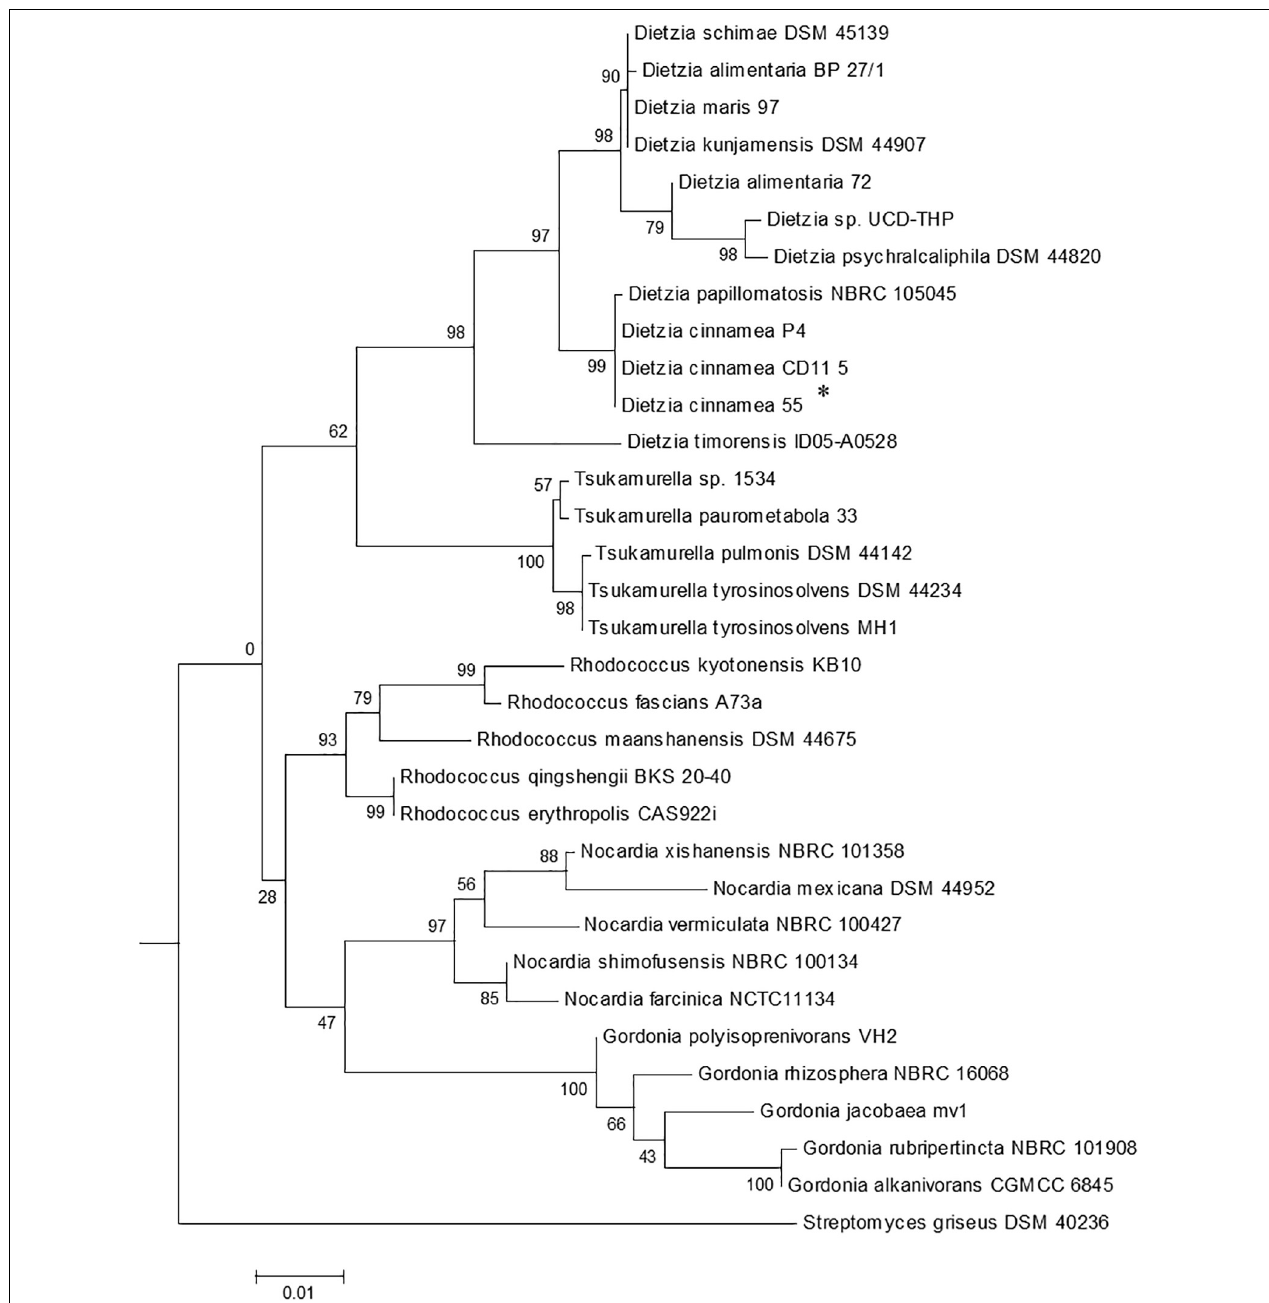
FIGURE 1 | The phylogenetic tree of Dietzia cinnamea 55 was constructed based on 16SrDNA sequences. Bootstrap values are based on 1000 replications. The asterisk indicates the strain for which the 16S rDNA sequence was determined in this study. Bar, 0.01 substitutions per